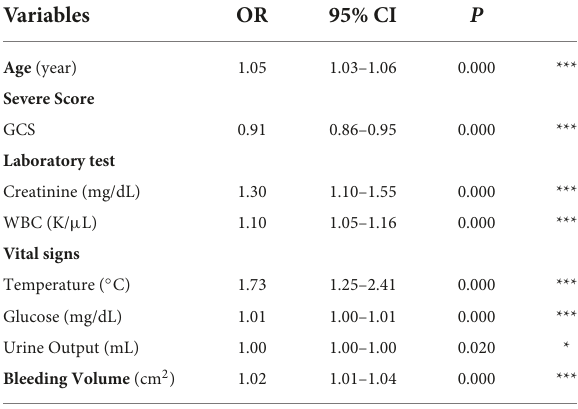
TABLE 2 Factors independently associated with 30-day mortality in ICH